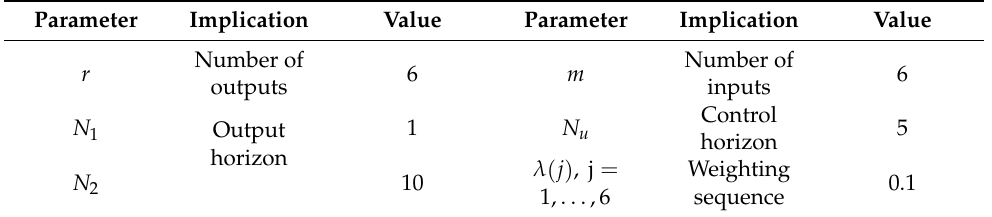
Table 1. Parameters of generalized predictive control (GPC).